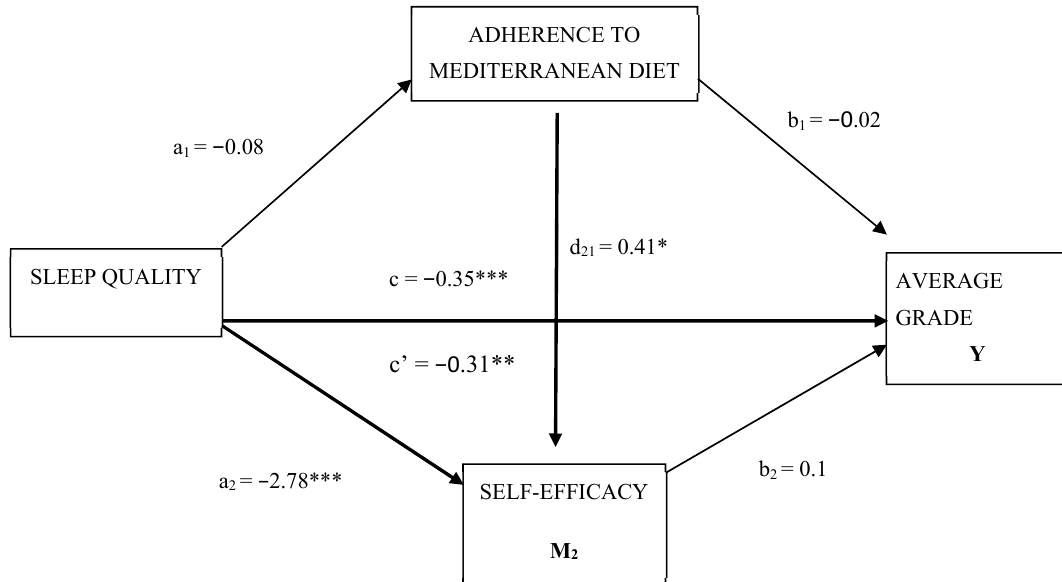
Figure 1. Multiple model of mediation of adherence to the Mediterranean diet and self-e ffi cacy in the relationship between the quality of sleep and the average grades of the students. X = independent variable; M1 = moderating variable 1; M2 = moderating variable 2; Y = dependent variable; a1 = e ff ect sleep quality on adherence to Mediterranean diet; b1 = e ff ect adherence to Mediterranean diet on average grade; a1 = e ff ect sleep quality on self-e ffi cacy; b2 = e ff ect self-e ffi cacy on average grade; d21 = e ff ect adherence to Mediterranean diet on self-e ffi cacy; c’ = direct e ff ect of X on Y with M1 and M2; c = total e ff ect of X on Y; * p < 0.05; ** p < 0.01; *** p < 0.001. Table 3. Total, direct and indirect e ff ect: multiple model of